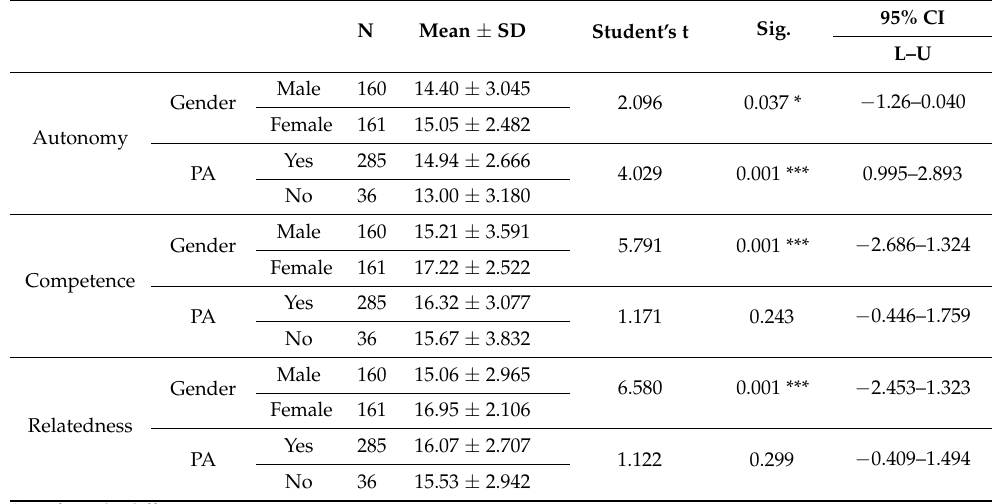
Table 2. Effect of the variables of gender and physical practice on autonomy, competence, and relatedness. N Mean ± SD Student’s t